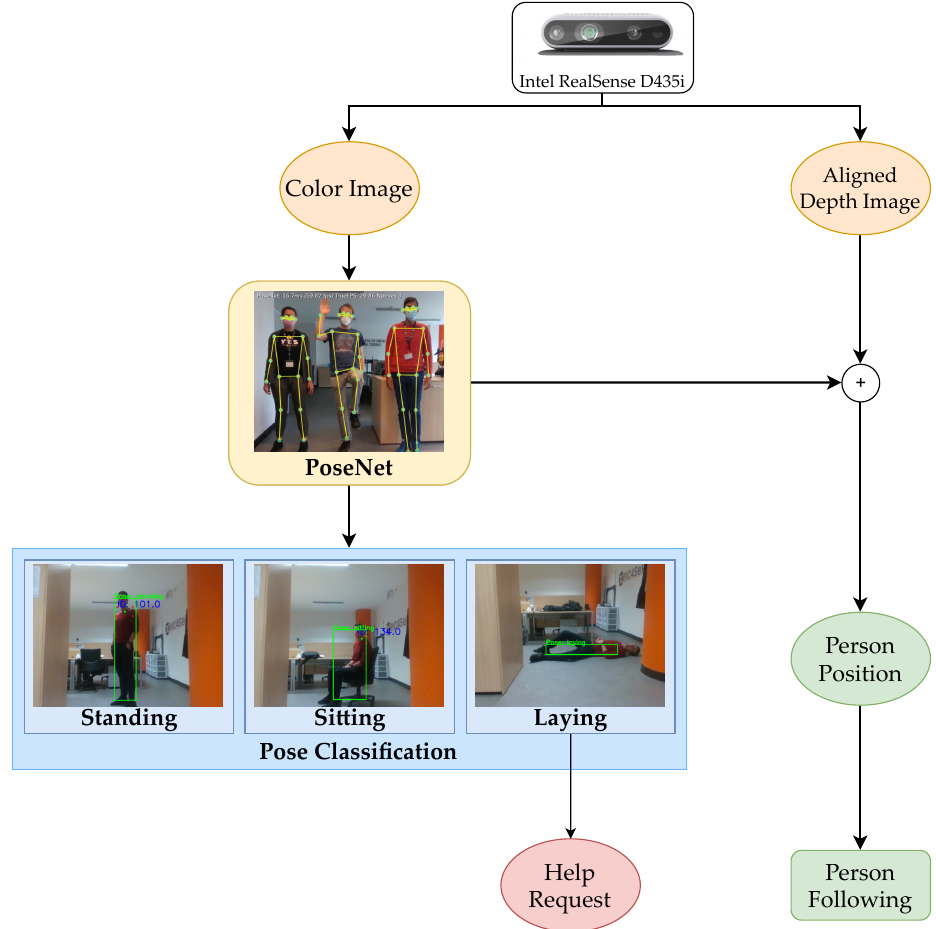
Figure 7. Representation diagram of the person identification system: the estimated pose of the person is continuously classified as standing, sitting, or laying, generating a help emergency request if necessary. Moreover, it is used to extract the dynamic goal coordinates for the person following